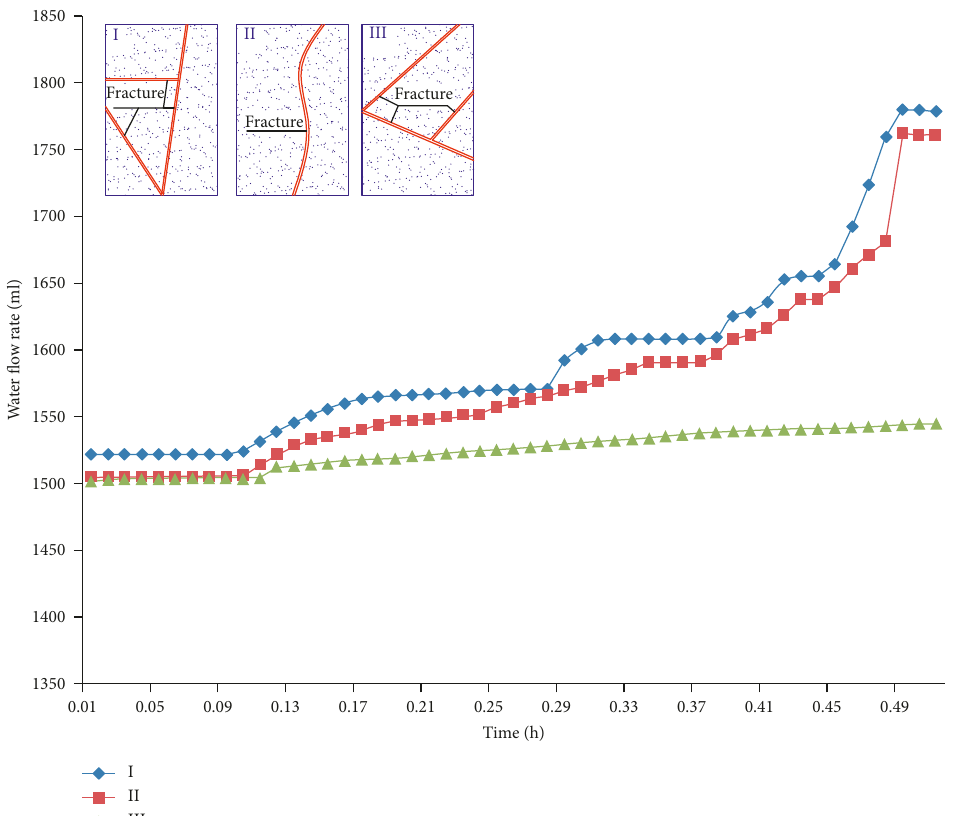
Figure 7: Curves of water flow rate of rock samples with different fracture distributions.